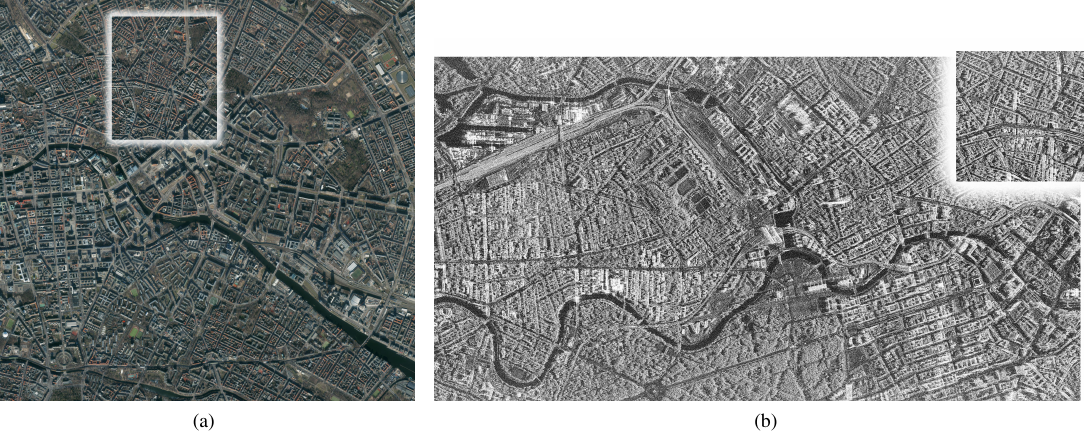
Figure 1. Illustration of data used for training and testing in this study. (a) Optical imagery, (b) SAR imagery. The large parts constitute the areas used for training, the smaller rectangles the common test area. For display purposes, the images are not shown to scale.